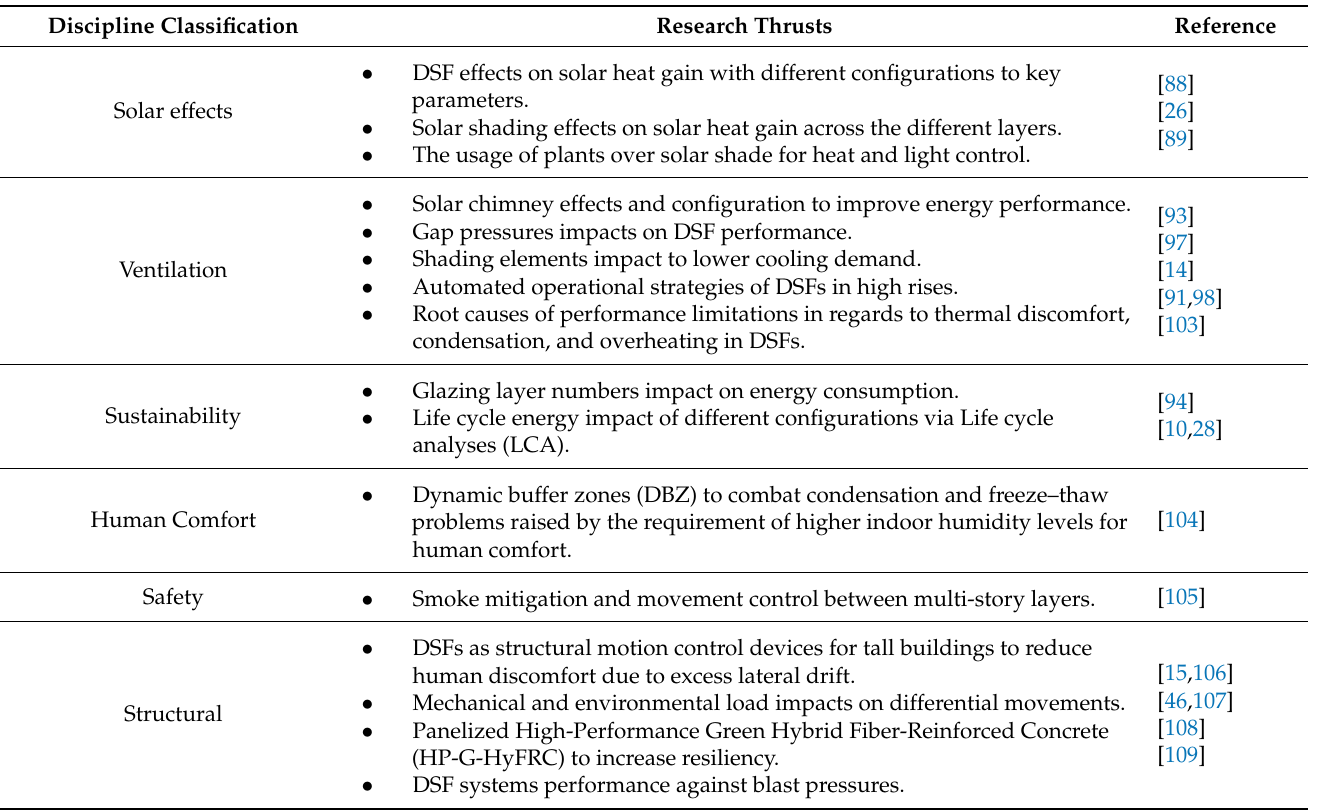
Table 9. Summary of Key DSF Research